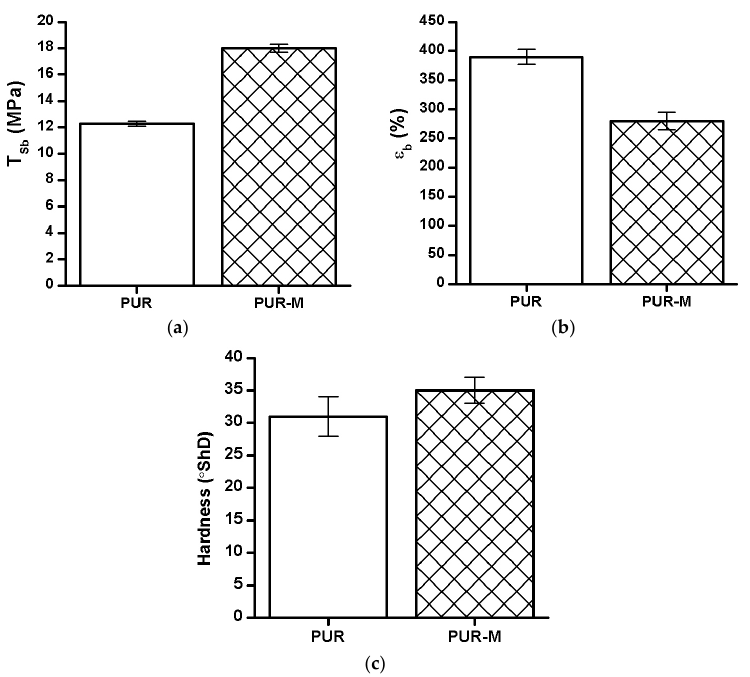
Figure 5. The T Sb ( a ), ε b ( b ), and hardness ( c ) of obtained PUR and PUR-M.